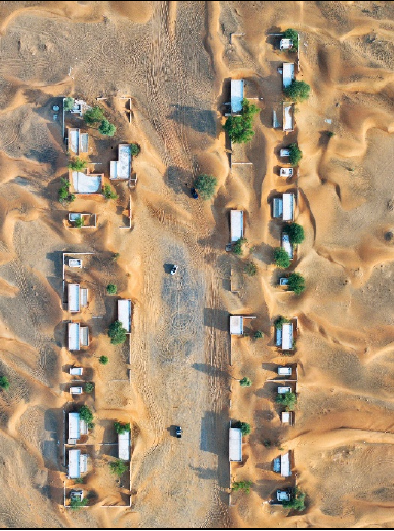
Figure 10. Aerial view of the Al ‐ Madam housing project. Credit: Shutterstock.com (accessed on 8 November 2022).